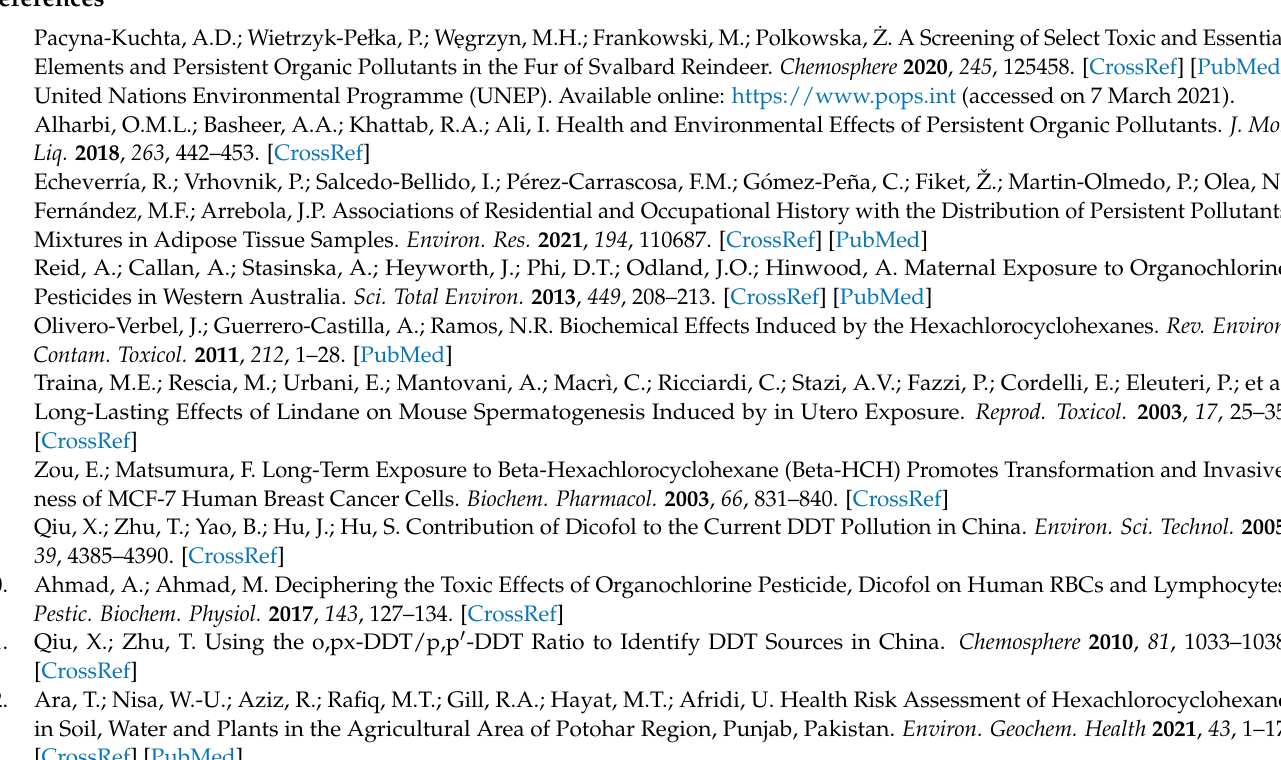
Table S4: Predictors of adipose tissue β -HCH concentrations in GraMo cohort according to the logistic multivariable model; Table S5: Review of studies on human biomonitoring of β -HCH, α -HCH and dicofol levels in the last 10